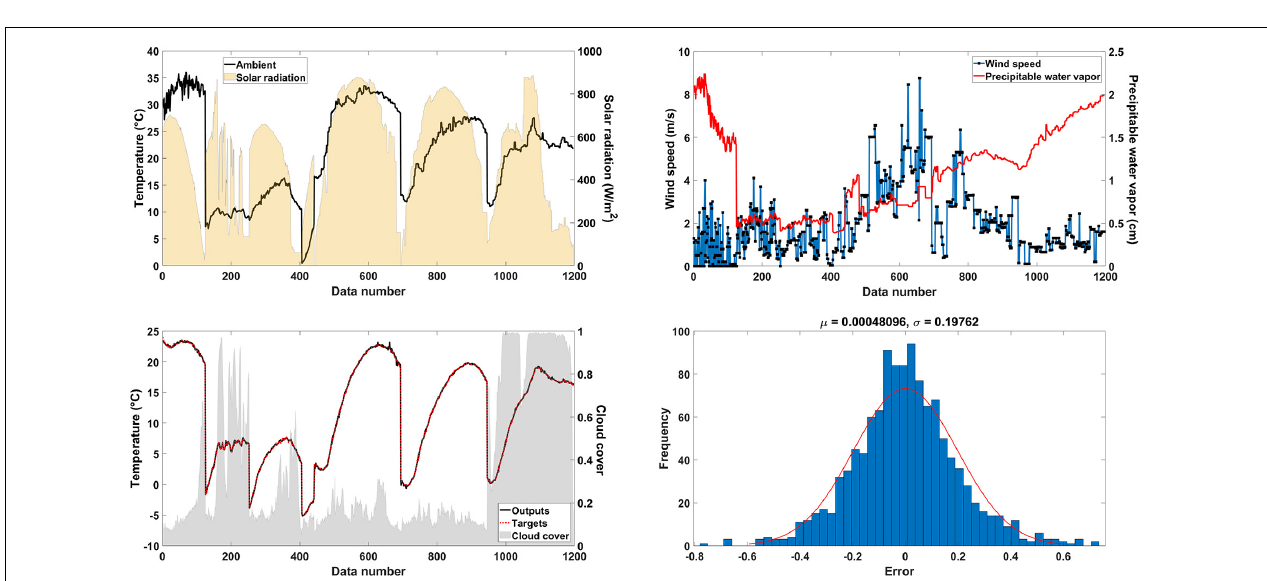
FIGURE 5 | Simulated and experimentally measured radiative cooling temperature (left) in August 28, 2017 and (right) March 9, 2018.